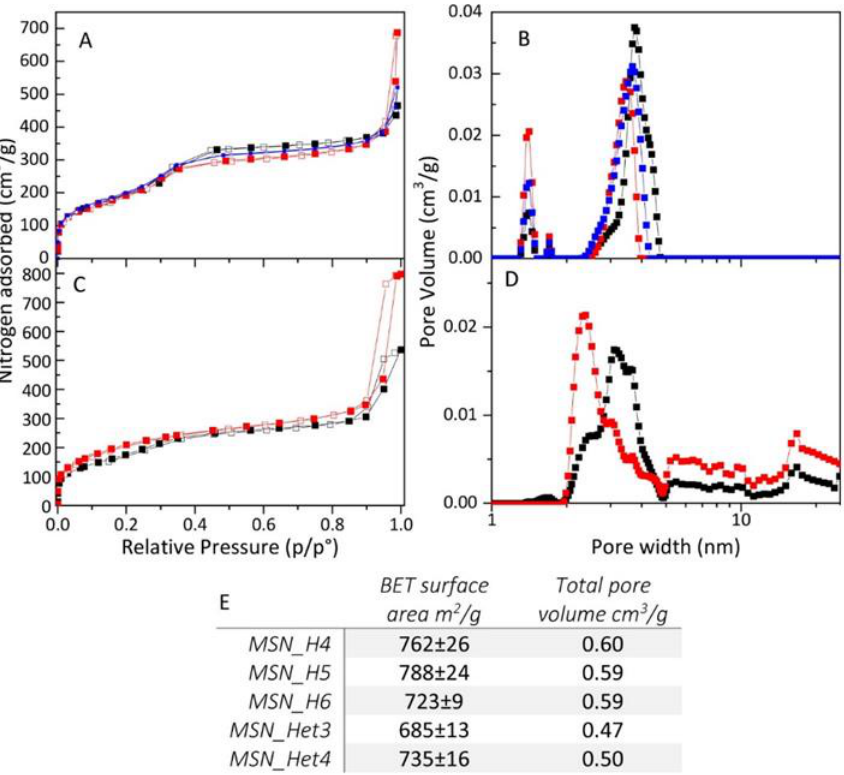
Figure 5. ( A − C ) N 2 adsorption-desorption isotherms and ( B , D ) pore width distributions by NLDFT of MSN_H4 (panel A, B red line), MSN_H5 (panel A, B blue line), MSN_H6 (panel A, B black line), MSN_Het3 (panel C, D, black line), MSN_Het4 (panel C, D red line); ( E ) table of MSNs samples surface area and pore volume.